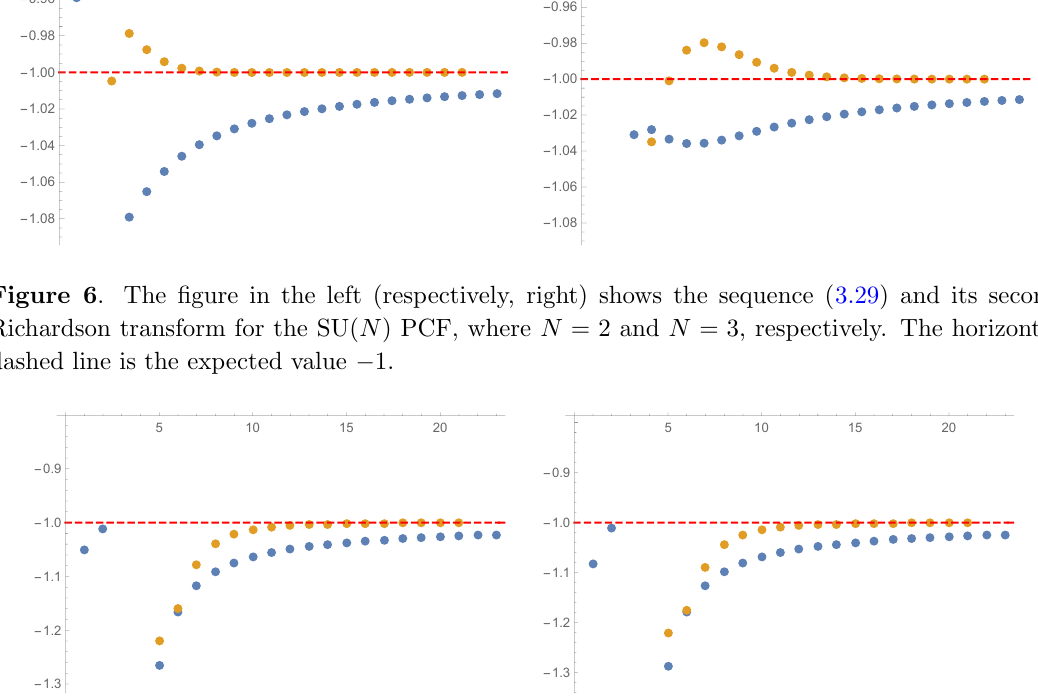
Figure 7 . The (cid:12)gure in the left (respectively, right) shows the sequence (3.29) and its second Richardson transform for the SU( N ) PCF with FKW conserved charges, where N = 2 and N = 7, respectively. The horizontal dashed line is the expected value (cid:0)